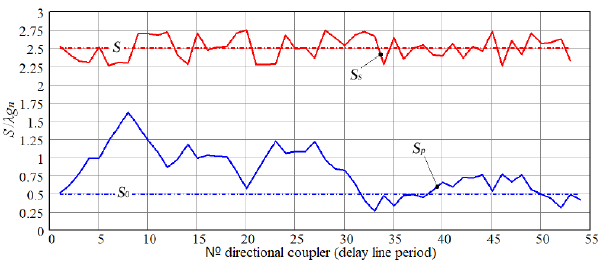
FIGURE 18. Normalized lengths of serial and parallel periods of delay lines were obtained by optimizing the power